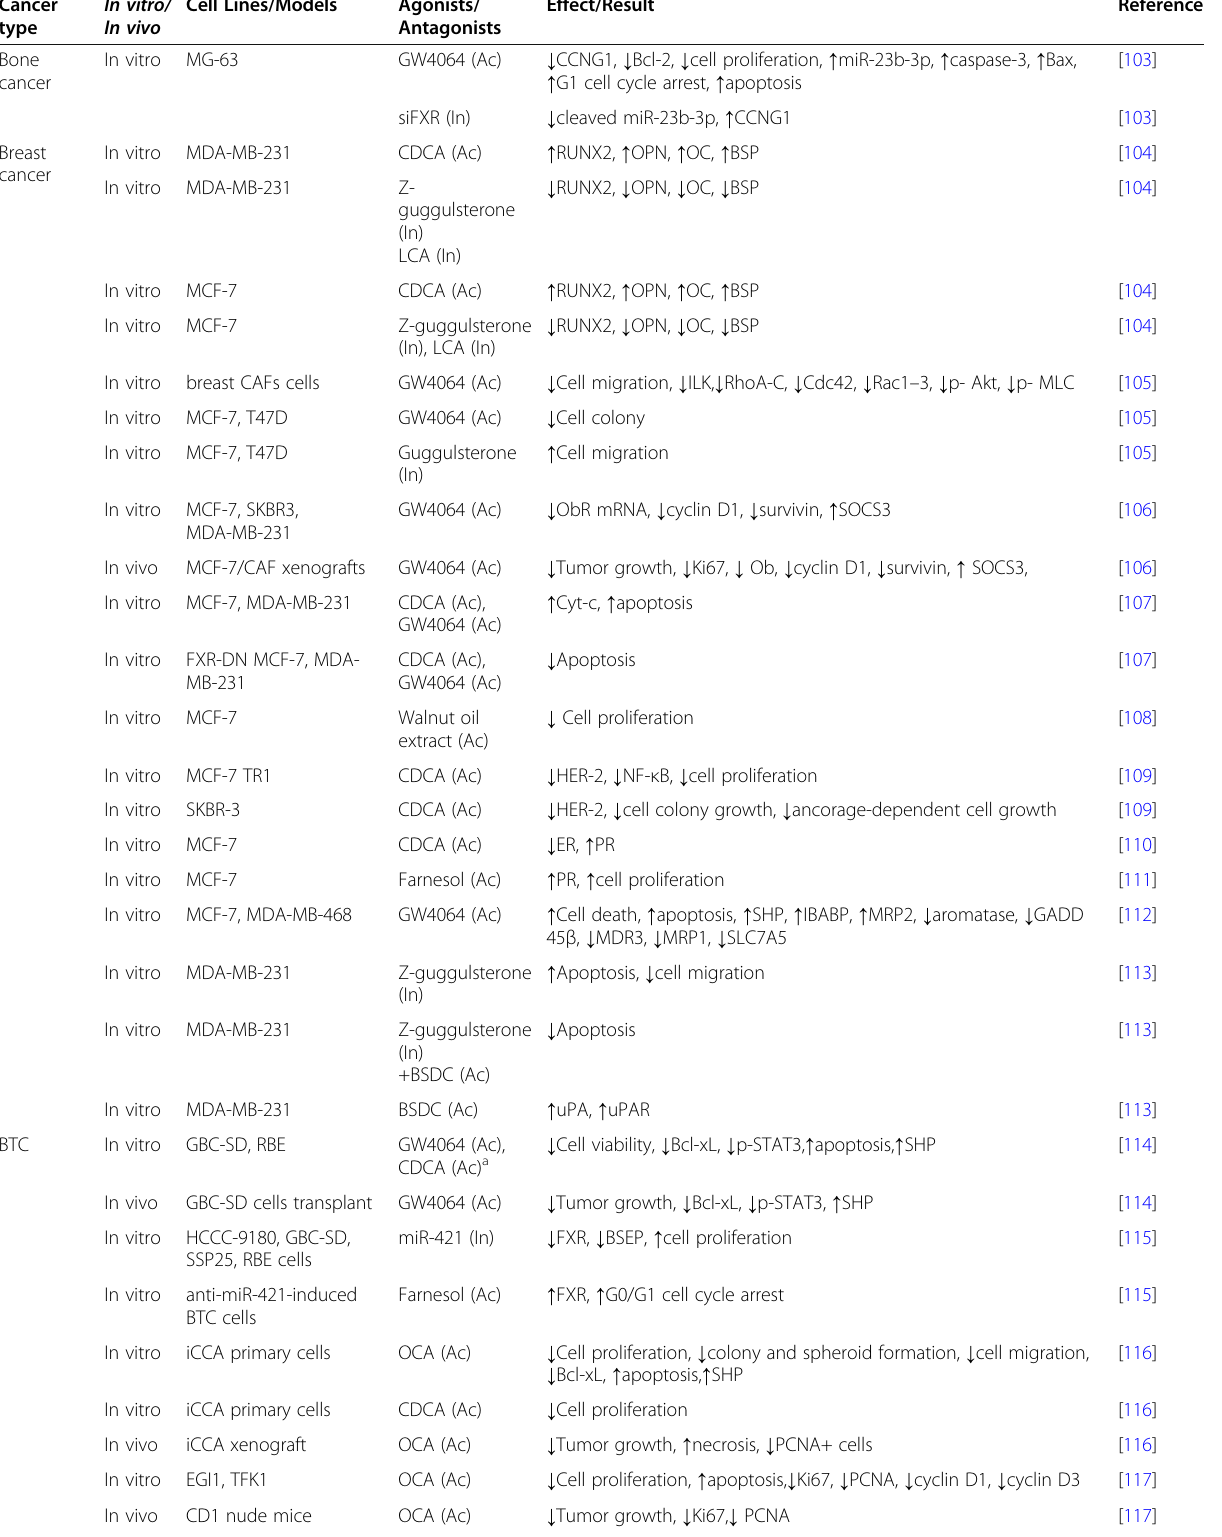
Table 1 Mechanistic role of FXR in various cancers in the presence of its agonists/antagonists Cancer